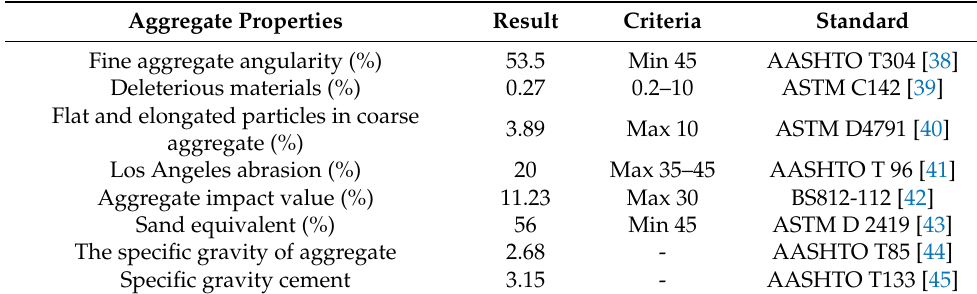
Table 6. Results of the virgin aggregate